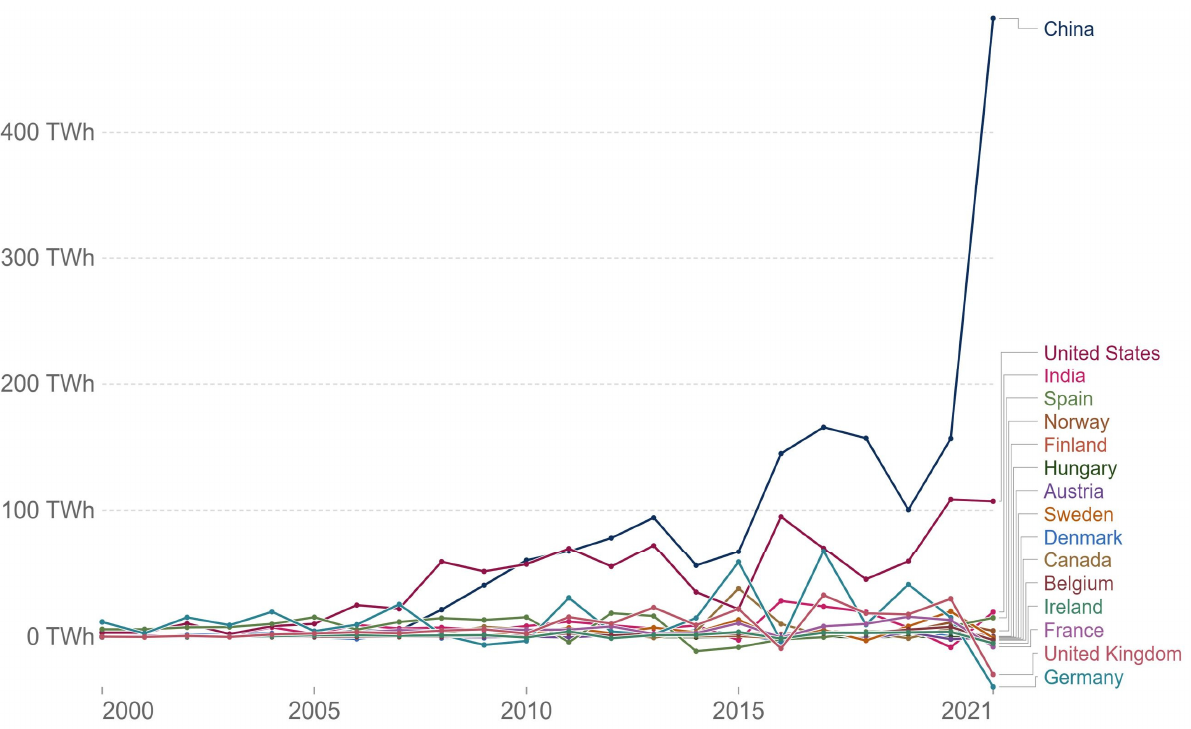
Figure 9. Annual change in wind energy generation across different country